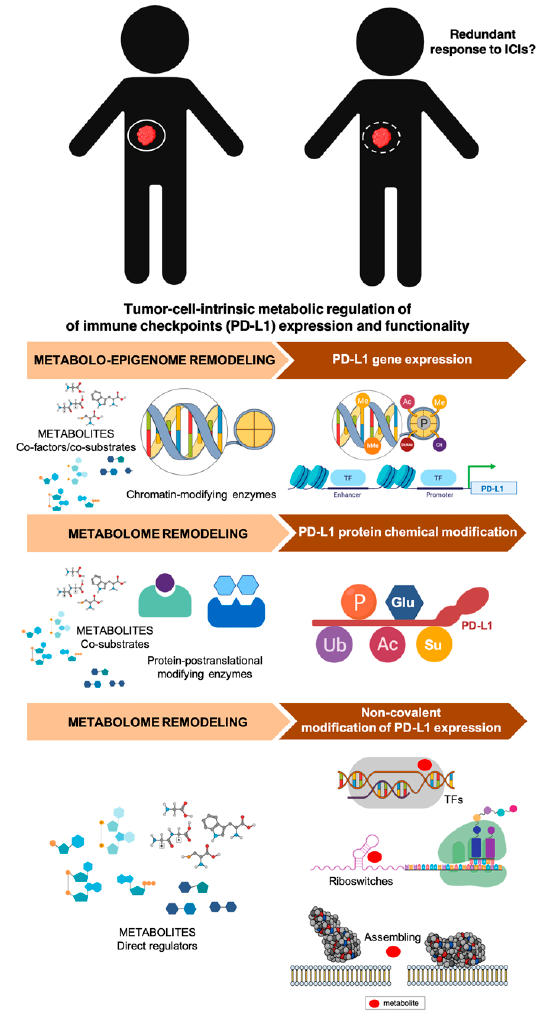
Figure 6. Metabolic mechanisms capable of regulating PD-L1 expression in cancer cells. PD-L1 expression can be modulated through various mechanisms including epigenetic and transcriptional regulation, post-translational, and non-covalent modifications. The metabolic regulation of these processes can limit tumor-specific PD-L1 expression and functionality, which might render PD-1 / PD-L1 targeting with immune checkpoint blockade redundant.